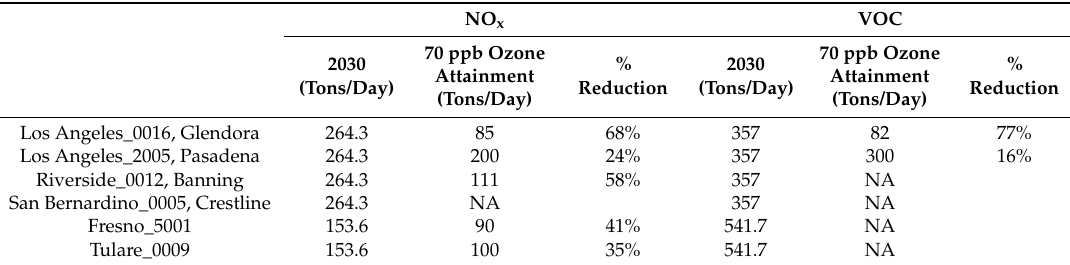
Table 3. List of non-attainment area monitoring sites in relation to future-year ozone design values at the projected NO x and VOC levels, and NO x or VOC level needed in tons/day and as a percentage of reduction to attain 70 ppb 4th highest maximum daily 8-h average (H4MDA8).